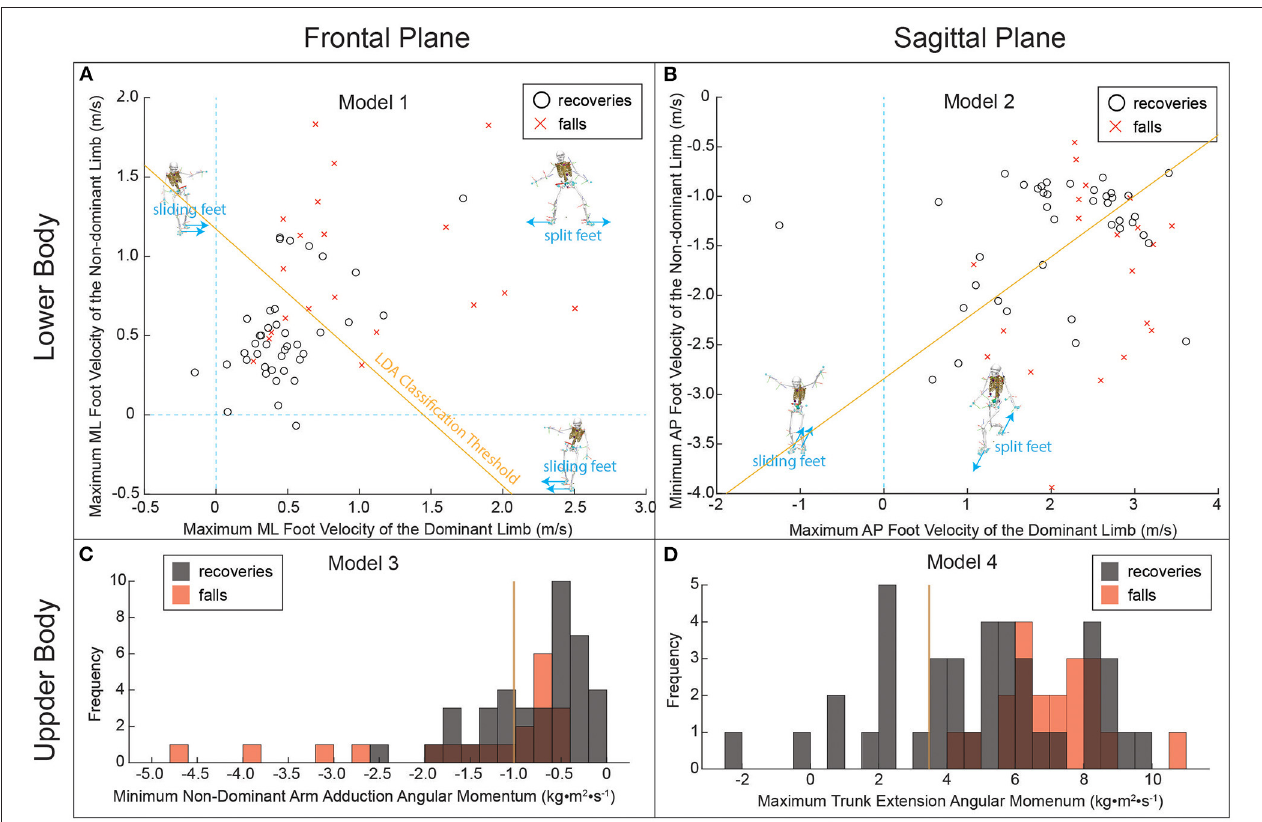
FIGURE 3 | Classification models to discriminate slip and fall trials from recoveries. Four LDA classification models were generated through a process of stepwise variable selection representing kinematic measurements during the slip in either the frontal plane or sagittal plane, and either the lower body or upper body. Solid yellow lines represent the LDA classification threshold where the LDA score is equal to zero. Dashed blue lines represent the separation between slip types (sliding feet or split feet). (A) Model 1 demonstrated the highest classification accuracy (73.3%). Falls occurred more often when slipping feet had greater maximum mediolateral velocity. (B) Model 2, derived solely from lower body sagittal plane kinematic measurements, demonstrated the second highest classification accuracy (accuracy = 68.3%). (C) Model 3 did not accurately discriminate falls from recoveries (accuracy = 61.7%) beyond the null accuracy (66.7%). (D) Model 4 demonstrated high sensitivity by correctly classifying all fall trials, but the overall accuracy was low (65.0%) due to the large number of recovery trials with maximum trunk extension velocity above the LDA classification threshold.